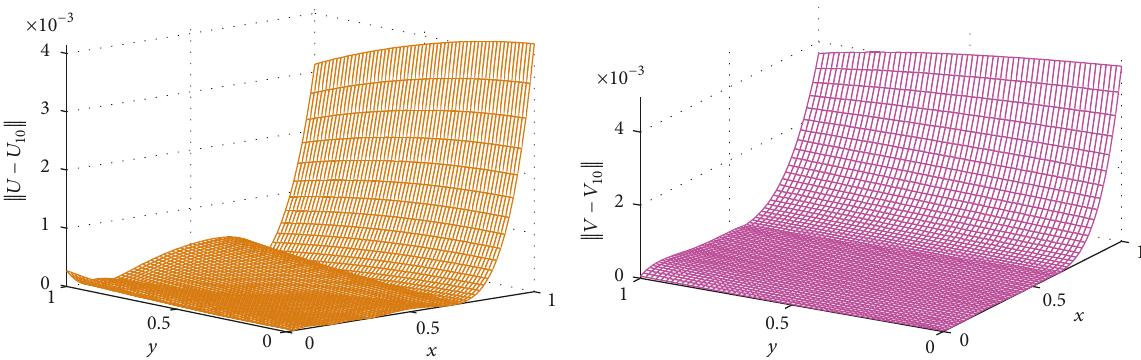
Figure 6: Maximum absolute error in 𝑈(𝑥,𝑦) and 𝑉(𝑥,𝑦) at 𝐾 = 8 for different values of 𝑥, 𝑦 for Problem 3.